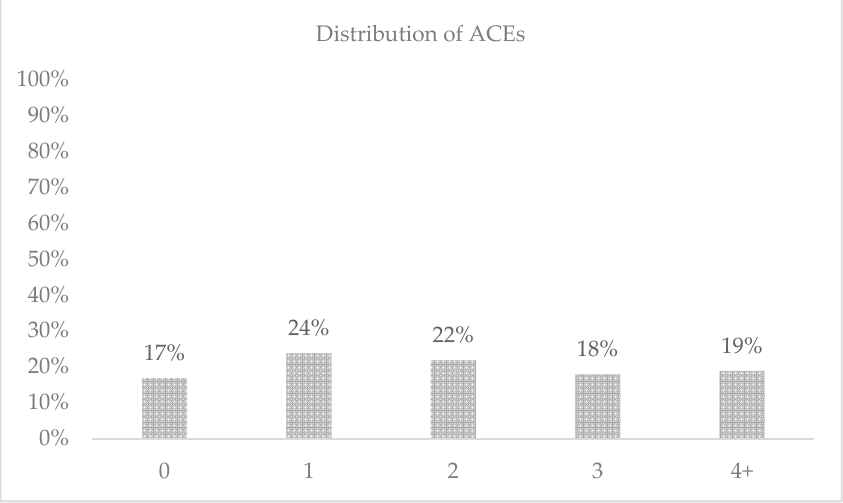
Figure 2. Distribution of ACEs Scores (weighted). n = 13,446.